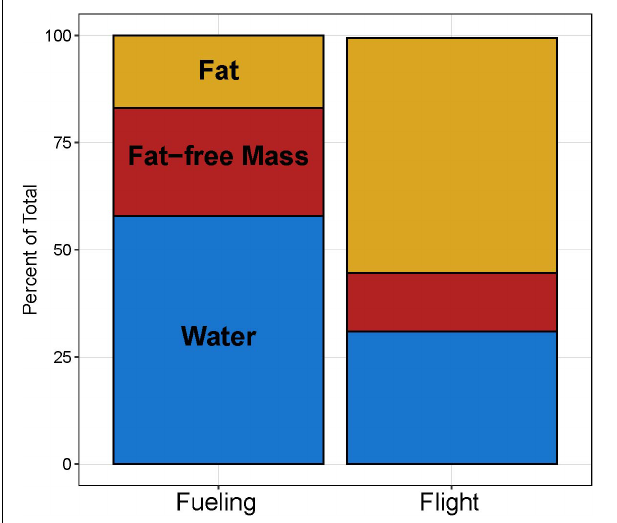
FIGURE 2 | Average composition [percent of total mass comprised by water (blue), fat-free tissues (red), and fat (yellow)] of juvenile bar-tailed godwits sampled in Alaska, United States, during the fueling (September 17–18; n = 2 females and 5 males) and flight (October 19; n = 9 males) annual-cycle stages of their first southward trans-Pacific